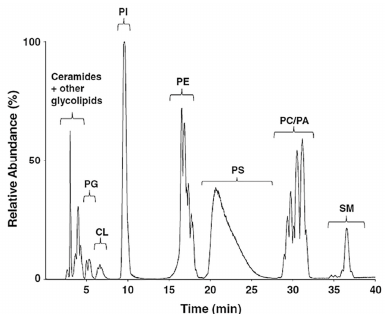
Figure 11. First dimension (1D) separation of rat brain phospholipids by normal-phase HPLC-MS/MS. Lipids were extracted from rat brain tissue (non-mitochondrial enriched) and were subjected to 1D LC-MS analysis on a normal-phase column. Individual lipid classes were identified based on retention times and MS/MS analyses. Major phospholipid and glycolipid fractions eluted in the following order; ceramide/glycolipids, PG (phosphatidylglycerols), CL (cardiolipins), PI (phosphatidylinositols), PE (phosphatidylethanolamines), PS (phosphatidylserines), PC (phosphatidylcholines)/PA (phosphatidic acids), SM (sphingomyelins), as indicated. A base peak intensity plot is shown. Reproduced with permission from [60]. Copyright Elsevier, 2012.